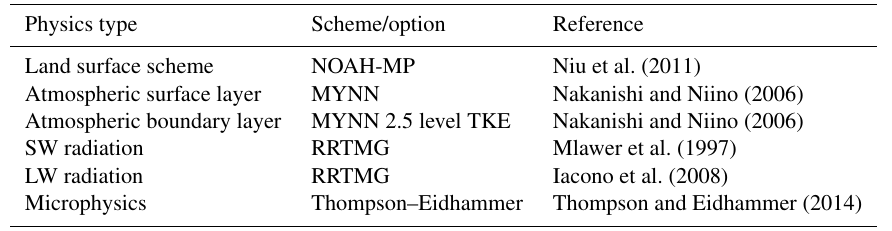
Table 1. Selected physics schemes in WRF for sub-grid